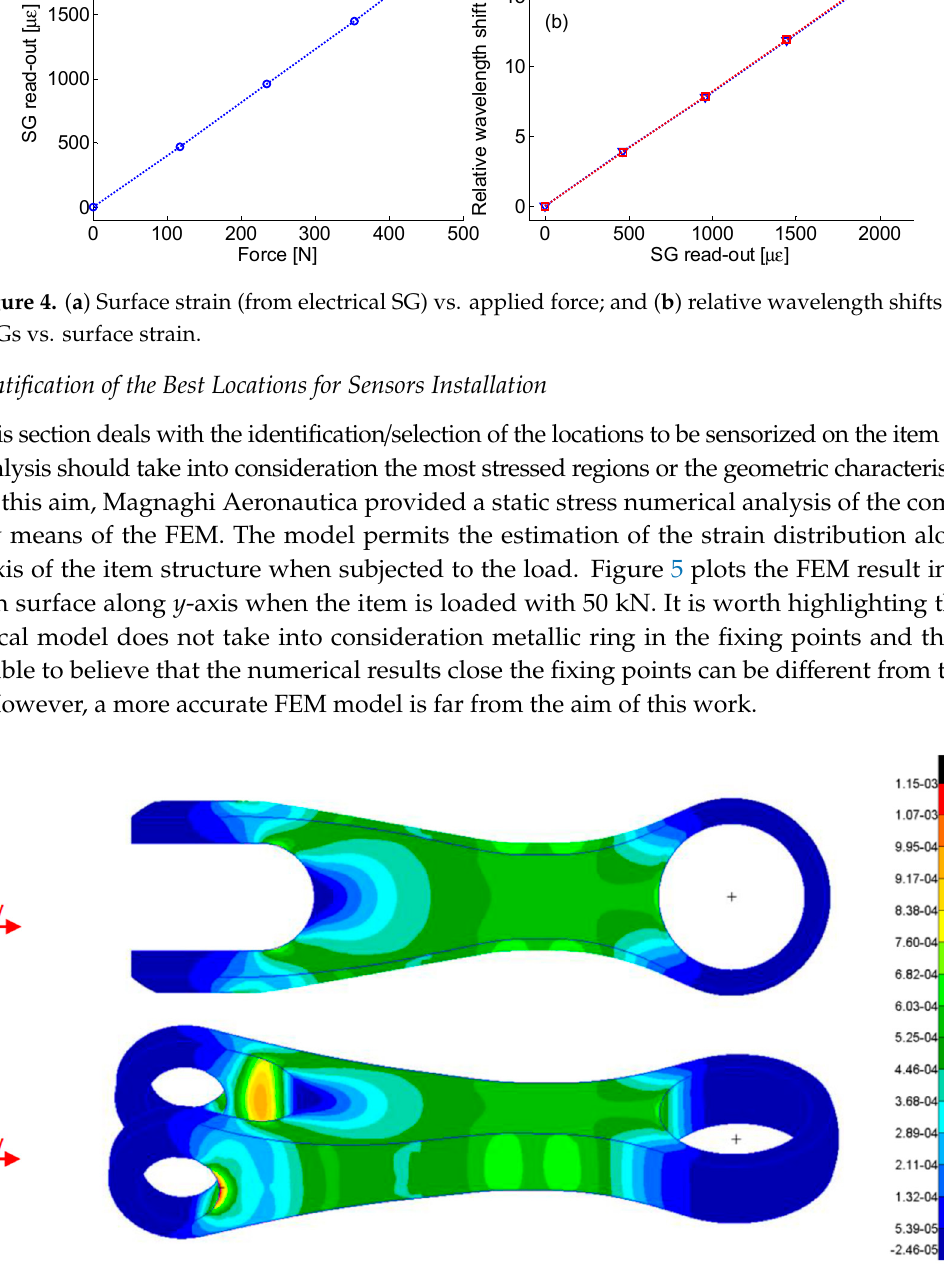
Figure 5. y -axis strain by finite element method (FEM) analysis of the composite